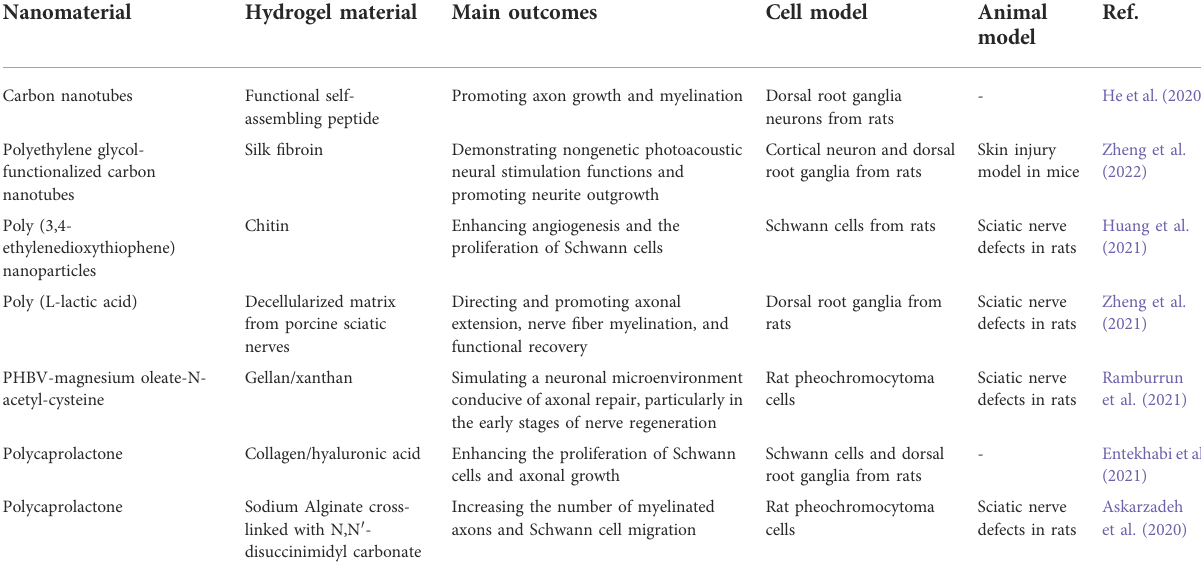
TABLE 3 The common researches of nanomaterial binding hydrogel in peripheral nerve